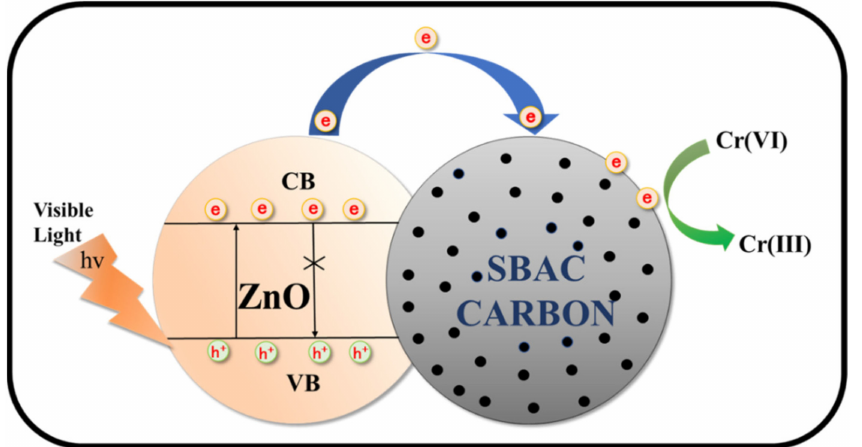
Figure 5. Mechanism for the photocatalytic reduction of Cr(VI) on the surface of ZnO-SBAC under visible light irradiation [103].